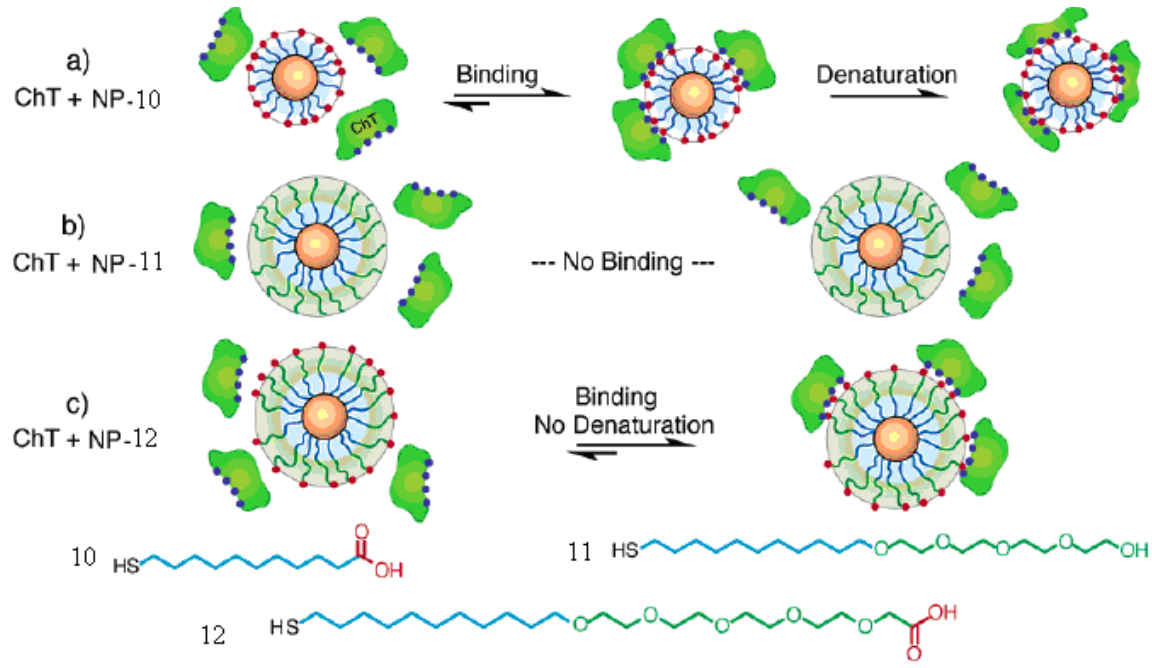
Figure 8. Ligands used for CdSe nanoparticles, and schematic depiction of protein- nanoparticle interactions (reproduced with permission from [39] © 2004, American Chemical